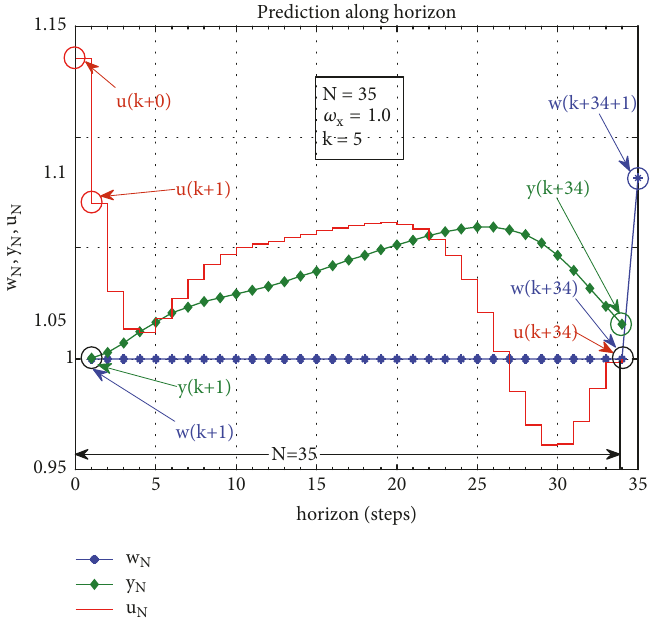
Figure 3: Prediction along control